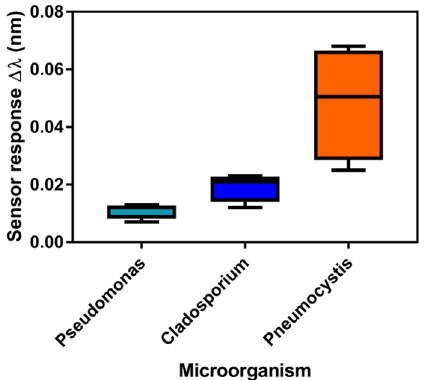
Figure 7. Analysis of mtLSU rRNA in clinical samples from patients infected by (i) Pseudomones ( n = 4), (ii) Cladosporium ( n = 4) and (iii) Pneumocystis ( n = 4), performed using the SPR biosensor